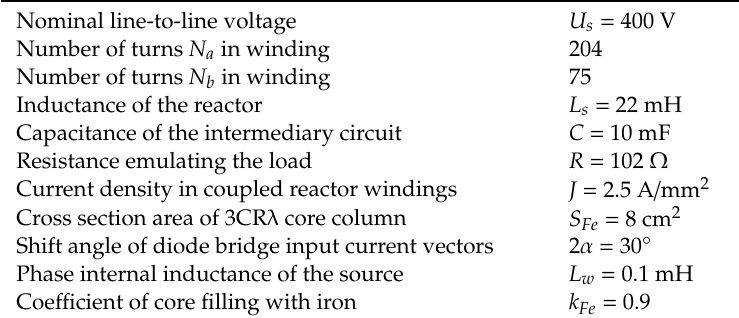
Table 2. Parameters of simulation and laboratory models of the 2 kVA 12-pulse rectifier.